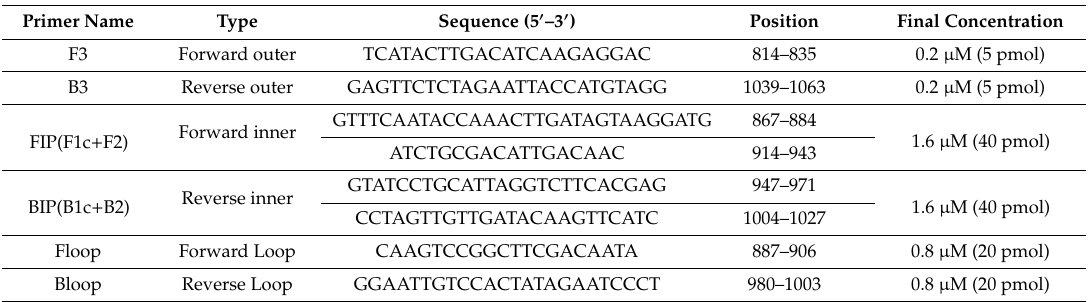
Table 2. Oligonucleotide primers used for RT-LAMP amplification of PPRV; position mapped